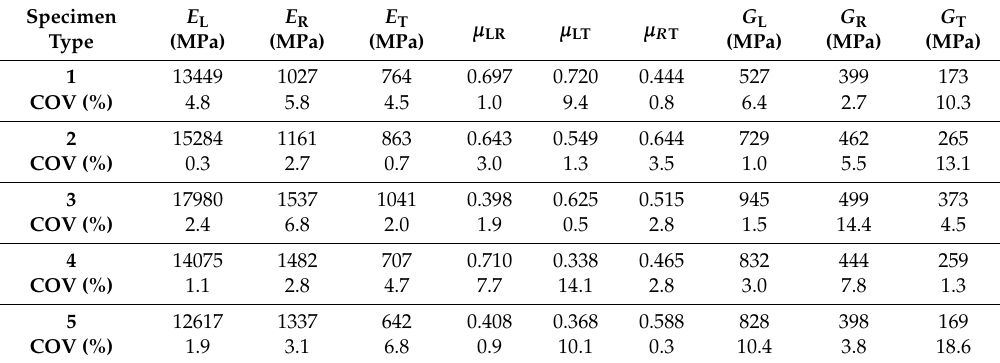
Table 3. Averages and coe ffi cient of variances (COVs) of elastic